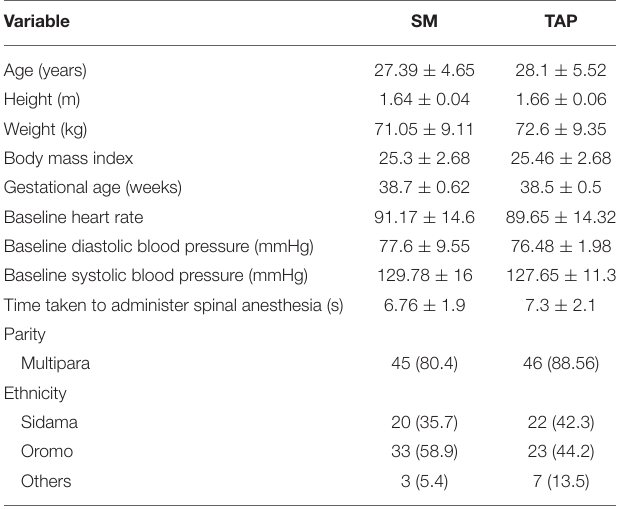
TABLE 1 | Sociodemographic characteristics of patients who underwent elective cesarean section (CS) under spinal anesthesia.